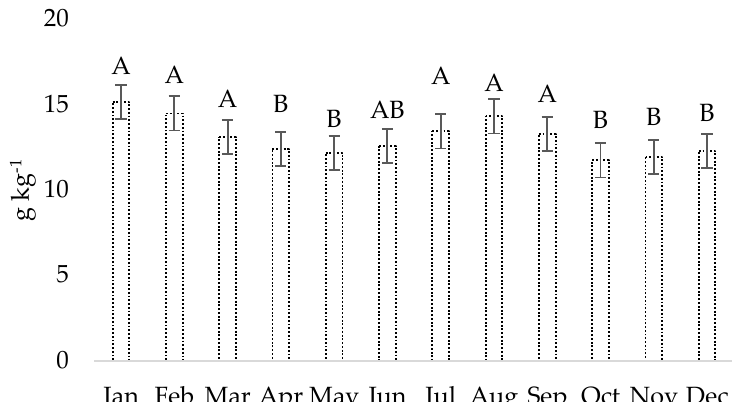
Figure 4. Crude protein of green leaf blade ( A ) and crude protein of green stem ( B ) (g kg −1 ) in signalgrass growing under Gliricidia and Mimosa during the experimental period. Data were averaged across replications and years. Small case letters are comparing treatments within each month in Figure 3A, and capital letters are comparing evaluations in Figure 3B. In both cases, equal letters are not different by the PDIFF adjusted by Tukey ( p > 0.05). SPS = silvopasture system.